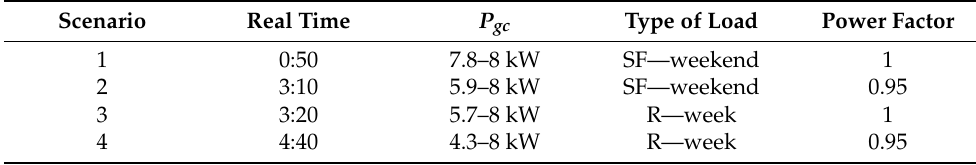
Table 1. Times of voltage condition overruns of the test object on 22 June.